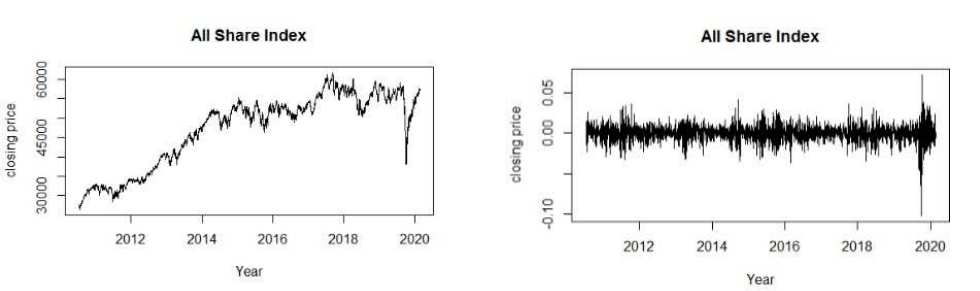
Figure 1. Time series plot of FTSE/JSE All Share Index prices (left) and one-day returns (right)